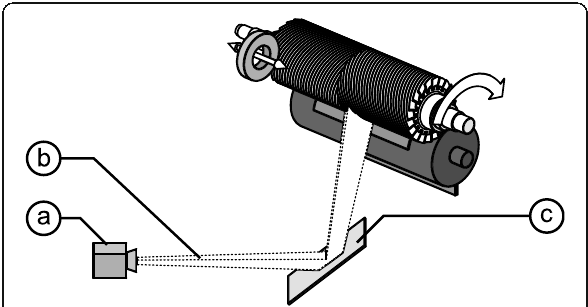
Fig. 2 Infrared imaging setup. a Camera. b Direction of